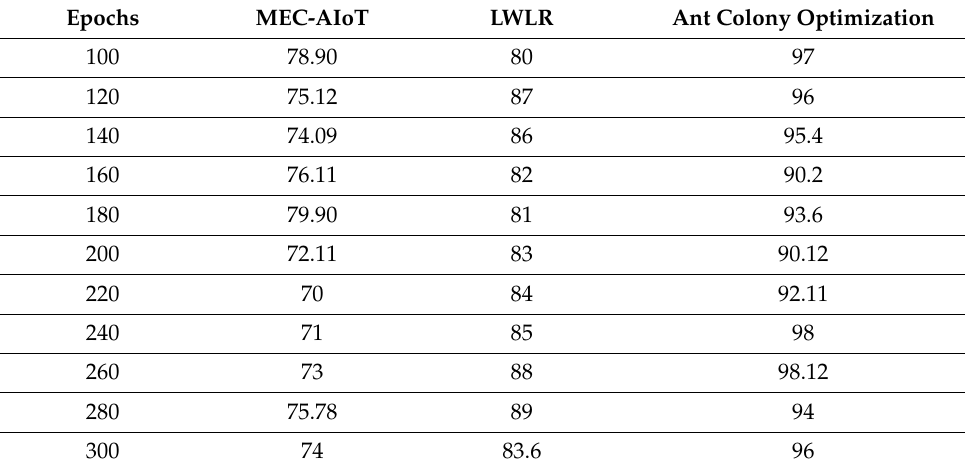
Table 3. The effectiveness of the ant colony optimization